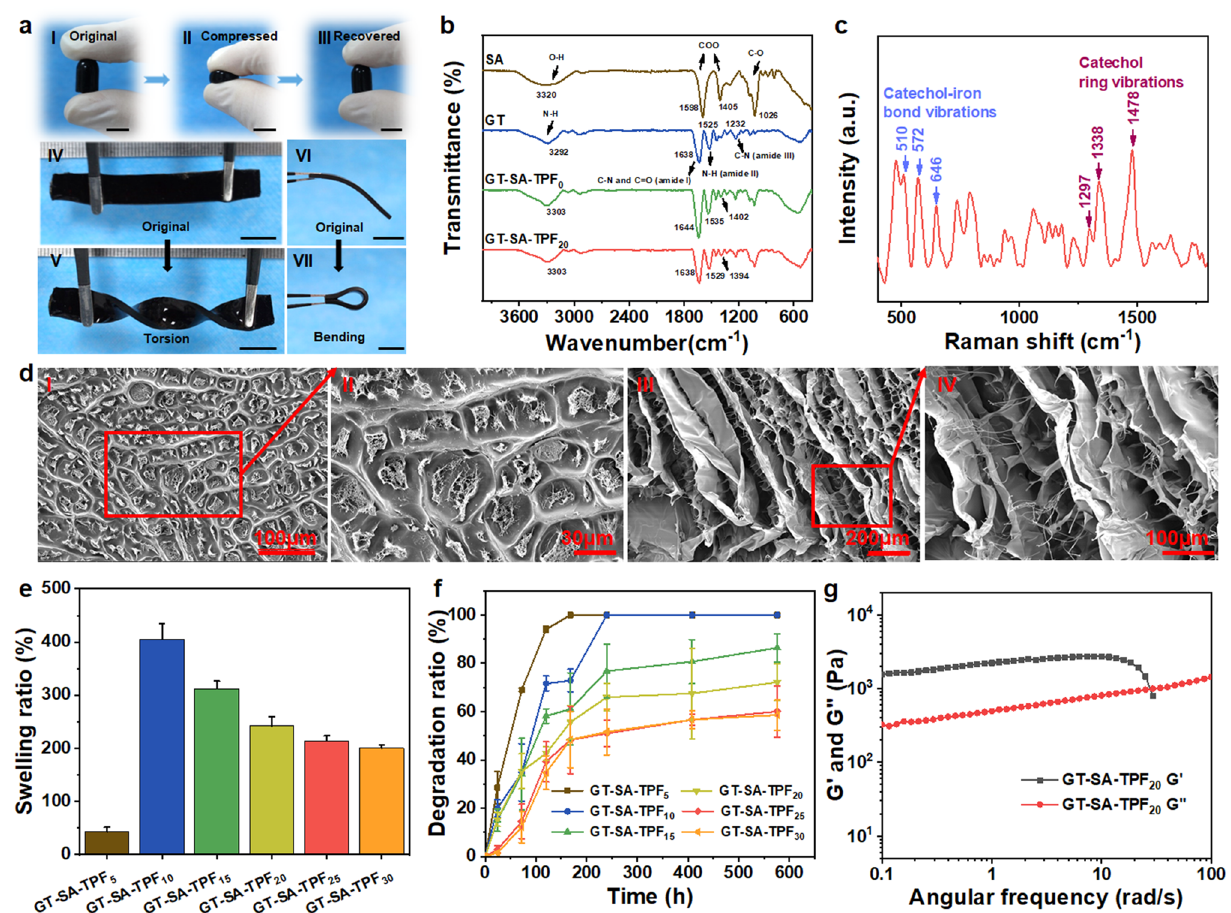
Fig. 2 Characterization of the prepared hydrogels. a Original state (I), compressed state (II) and recovered state (III) of the hydrogel, and the original state (IV and VI) and distorted state (V and VII), scale bar: 1 cm. b FT-IR spectra of the samples. c The Raman spectrum of the GT- SA-TPF 20 hydrogel sample. d SEM images of the lyophilized original (I and II) and swollen GT-SA-TPF 20 hydrogel sample (III and IV). e The swelling ratio and f degradable behavior of the hydrogel samples. g Angular frequency sweep curve of GT-SA-TPF 20 hydrogel